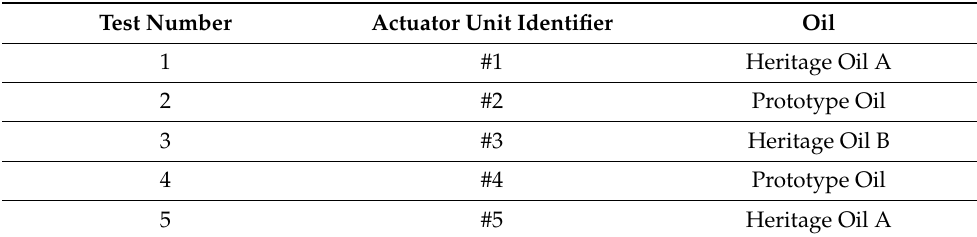
Table 2. Test samples and order of test